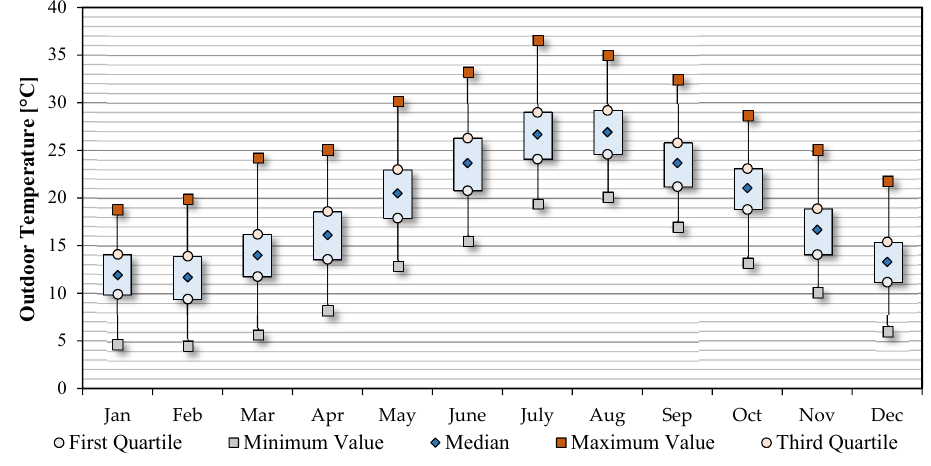
Figure 2. Site air temperature analysis.